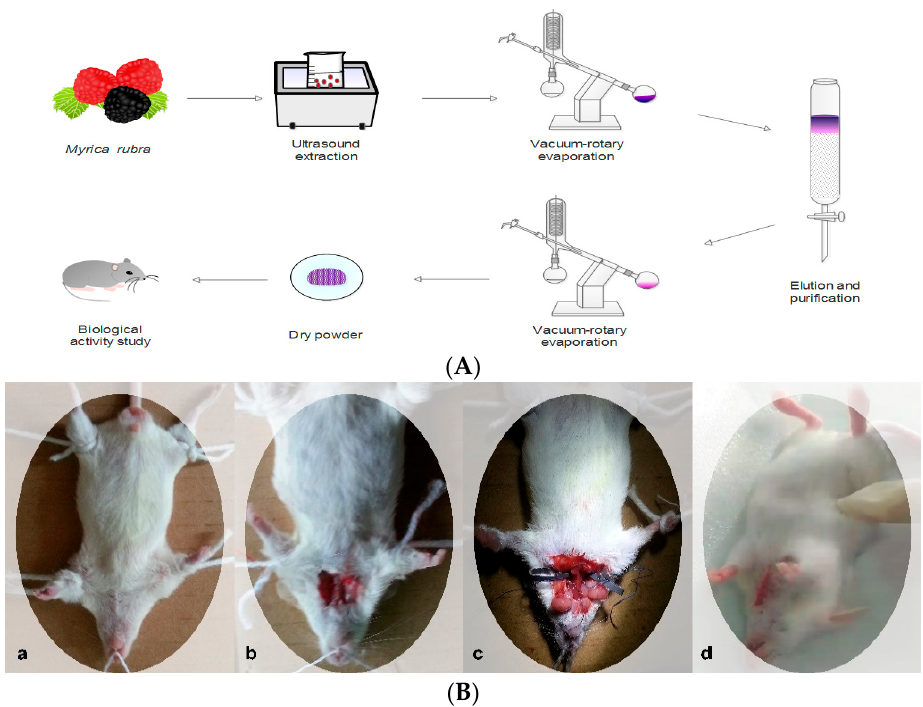
Figure 2. Experimental flow chart. ( A ) Process flow chart for the extraction and purification of total anthocyanin. ( B ) Experimental process of inducing cerebral ischemia-reperfusion (I/R) injury in mice: ( a ) anesthesia and fixation; ( b ) exposure of the common carotid arteries; ( c ) blocking of the blood circulation; ( d ) suture and recovery.